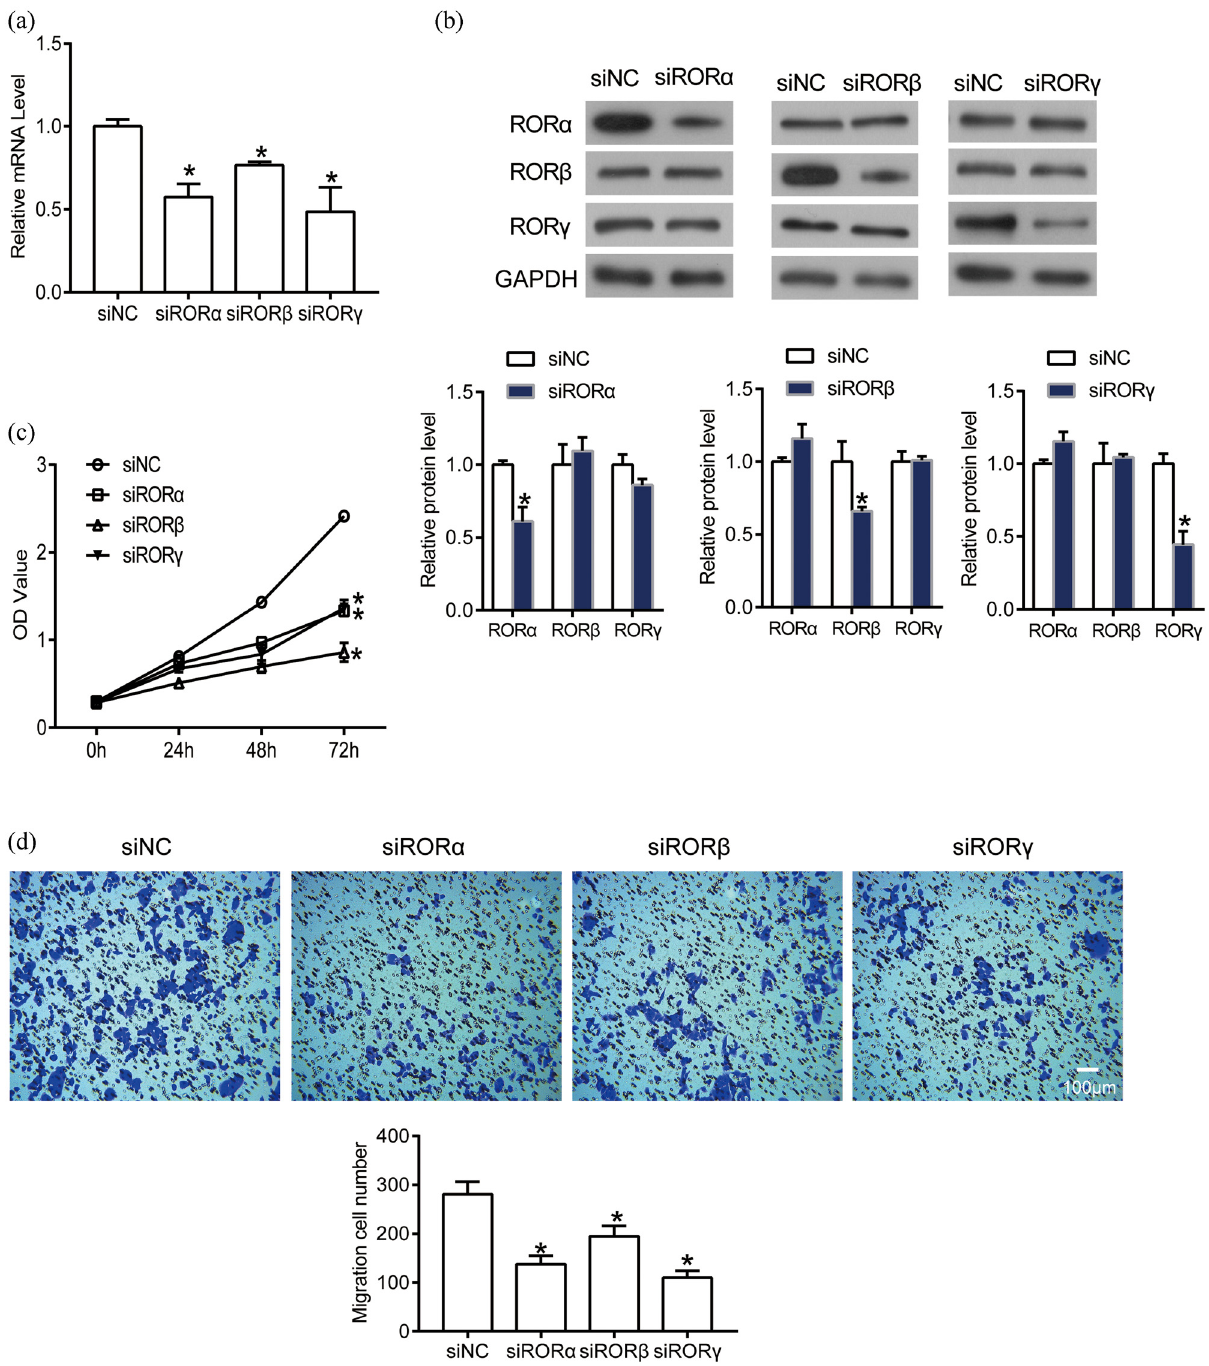
Figure 6: Knockdown of ROR α , ROR β , or ROR γ inhibited cell proliferation and migration. The mRNA ( a ) and protein ( b ) levels of ROR α , ROR β , and ROR γ in NC and knockdown cells were detected by qPCR and Western blot, respectively. ( c ) The proliferation of cells with siNC, siROR α , siROR β , or siROR γ transfection was con fi rmed by CCK - 8 assay. ( d ) The migration of cells with siNC, siROR α , siROR β , or siROR γ transfection was detected by transwell. * P <